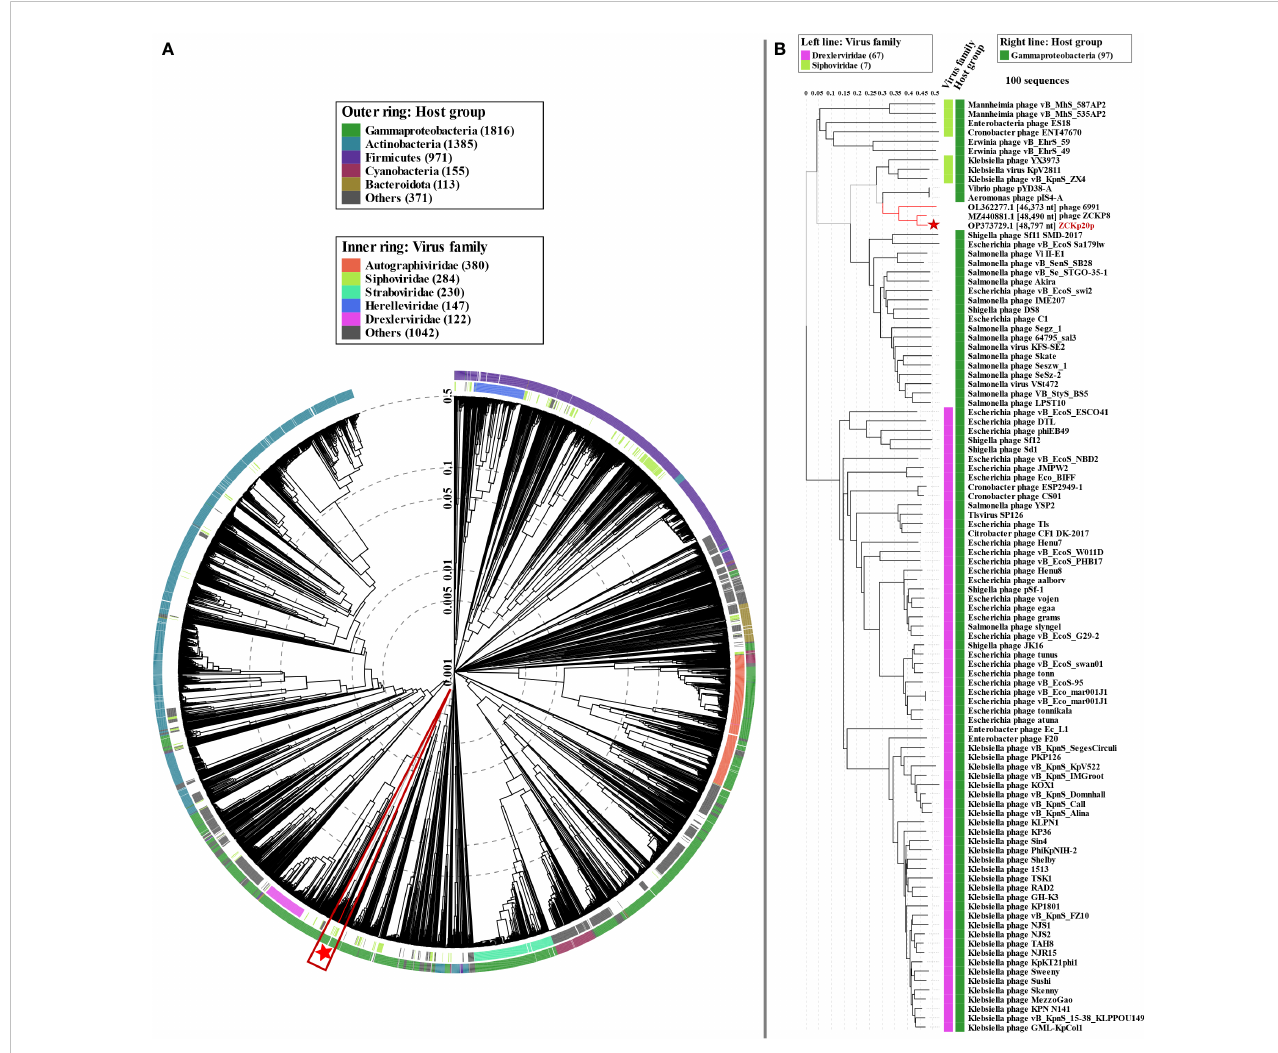
FIGURE 10 Proteomic tree of phage vB_Kpn_ZCKp20p. (A) Circular proteomic tree based on genome-wide similarities of phage vB_Kpn_ZCKp20p (marked with a red star), top matches on BLASTn, and closely related reference phage genomes. (B) Rectangular proteomic tree of phage vB_Kpn_ZCKp20p and 99 phages with highest ViPTree S G